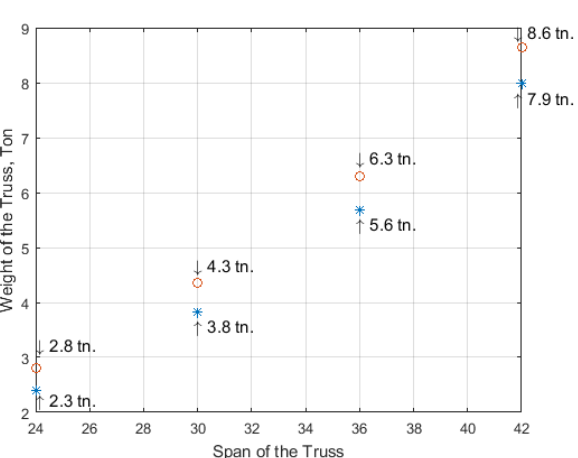
Figure 9. Comparative analysis of prestressed arched trusses calculated with the classical (o) and optimized (*) methods.